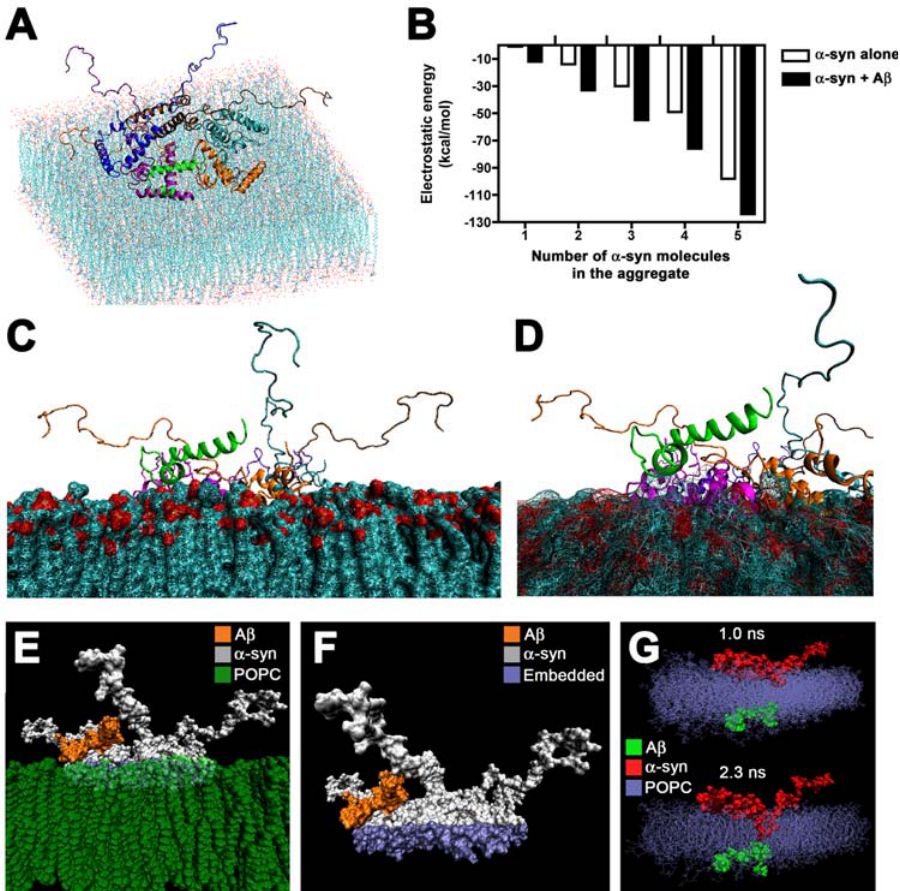
Figure 3. Modeling and energies of interaction between A b and a -syn oligomers docked on the membrane. ( A ) Conformation of lowest-energy complex between a -syn pentamer and 2 ns A b conformer on the membrane. ( B ) Calculated values for the most favorable energies of interaction between one A b monomer and an a -syn monomer, dimer, trimer, tetramer or pentamer. Compared to a -syn homomeric species composed of the same number of a -syn molecules, hybrid A b / a -syn multimers were more stable and had more favorable (lower) electrostatic energies of interaction. ( C, D ) Hybrid A b / a -syn multimers formed ring-like structures that embedded in the membrane after 350–800 ps of simulation. ( E ) Space-filled model of A b (orange)/ a -syn (gray) multimer embedded in the membrane (green) at a depth of 1.6A˚ after 800 ps of MD simulation. ( F ) Space-filled model of A b (orange)/ a -syn (gray) multimer showing the depth of 1.6A˚ (purple) that the complex embedded into the membrane (POPC) after 800 ps of MD simulation. ( G ) Space-filled model of A b (green) and a -syn (red) monomer initially situated on opposite sides of the POPC membrane showing penetration of the A b and a -syn molecules into the membrane and interaction between the two after 2.3 ns of MD simulation.